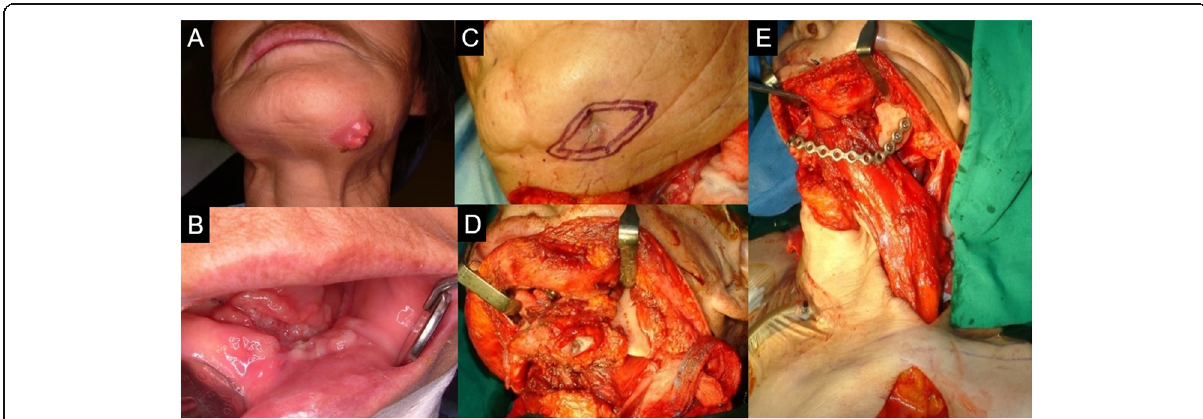
Fig. 1 a , b Lesion on extraoral and intraoral site. c , d Extraoral excision outline and postoperative mandible state. e PMMC flap transfer to the